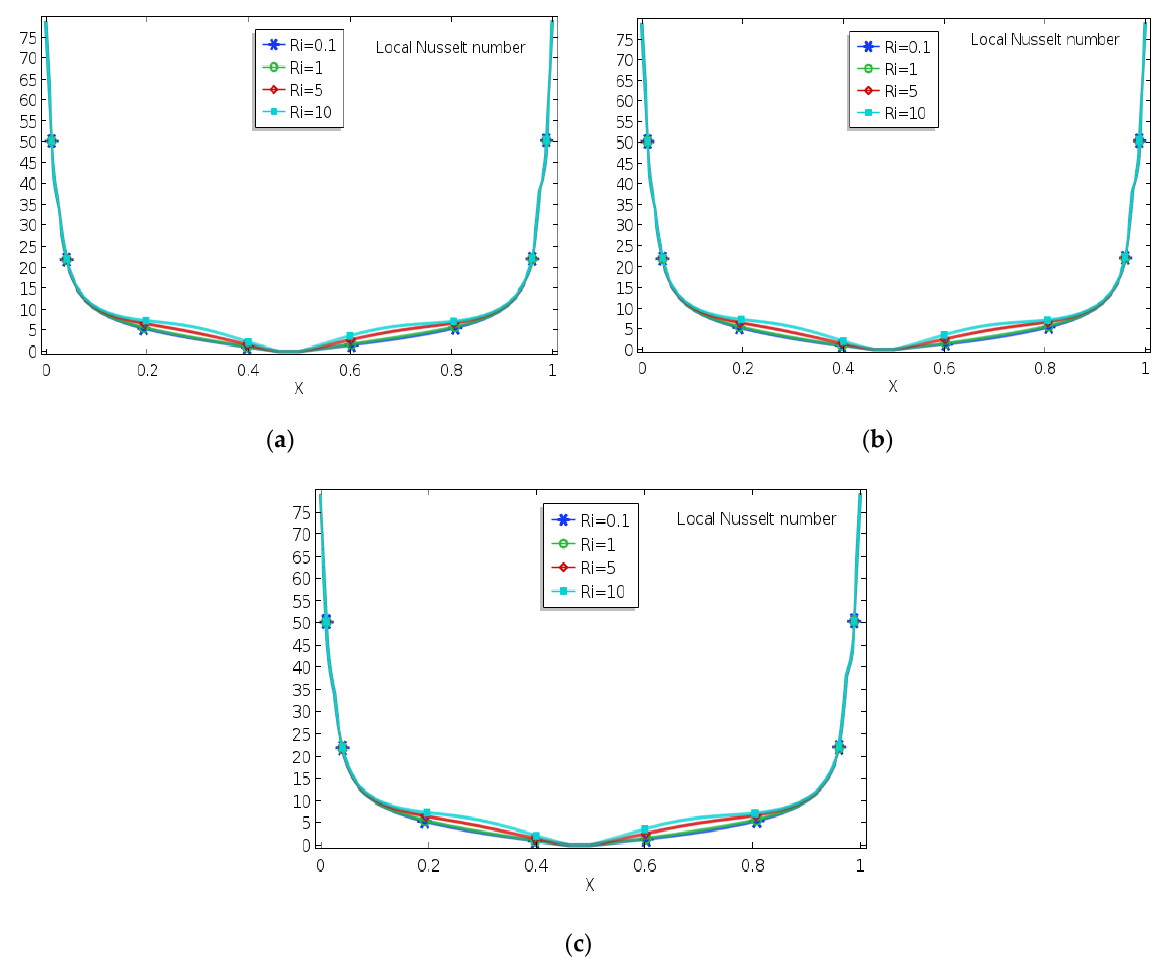
Figure 7. Nu L for ( a ) L = 0.25, ( b ) L = 0.35 ( c ) L = 0.45 at Re = 100 and λ = 2.